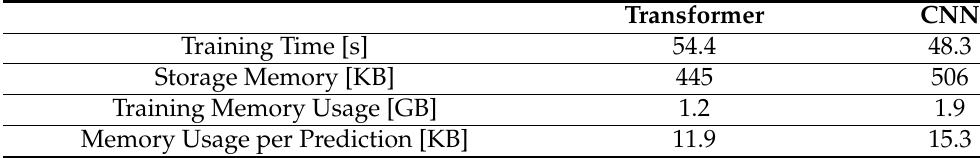
Table A2. Summary comparison table between Transformer and CNN model performance for training time and computational